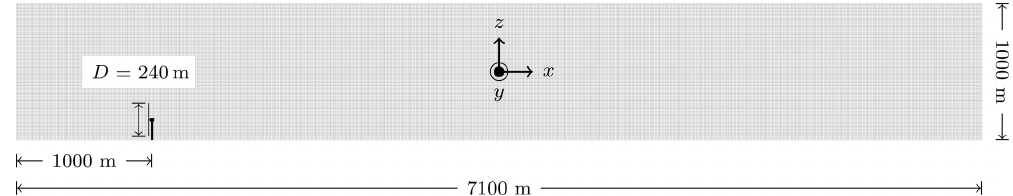
Figure 2. IEA-15MW LES domain with turbine and grid spacing to scale. All dimensions in meters unless otherwise noted.